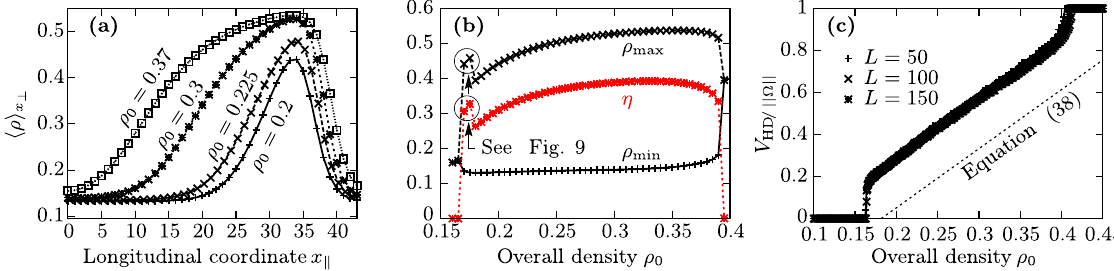
FIG. 4. Density variation inside the DSP parameter regime ( σ ¼ σ 0 ¼ 0 . 5 ). (a) Typical profiles of wavelike patterns inside the density- segregated phase for various overall densities ρ 0 . The asymmetry of the wave profiles increases with density. ( ρ values considered.) (b) Density segregation as a function of the overall density ρ 0 . Data points have been obtained by quasistatically changing ρ 0 starting at a stationary traveling-wave pattern at ρ 0 ¼ 0 . 25 . As a consequence of hysteresis effects [see Figs. 3(b) and 5], phase-space coexistence can be observed between the DSP and the IHP at low densities, as well as between the DSP and the SHP at higher densities. (c) Surface fraction of the HD phase as a function of the overall density ρ 0 . Within the DSP, the surface fraction varies virtually linearly with ρ 0 in agreement with the mean-field picture [Eq. (38)]. At the transitions IHP → DSP and DSP → SHP, the surface fraction exhibits a discontinuous